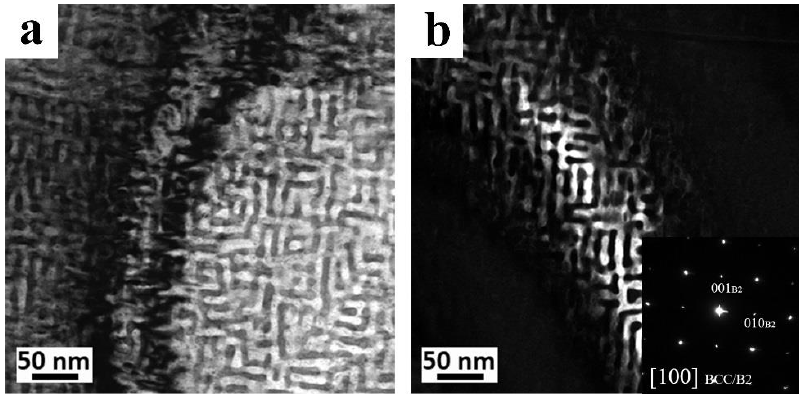
Figure 5. TEM study of the AlCoCrFe (w / o Ni) alloy. ( a , b ) Bright field (BF) and dark field (DF) (taken in g = (010) B2 ) TEM images. Areas of B2 phase are illuminated in image ( b ). SAED pattern taken along [100] B2 / BCC orientation is shown in the inset.